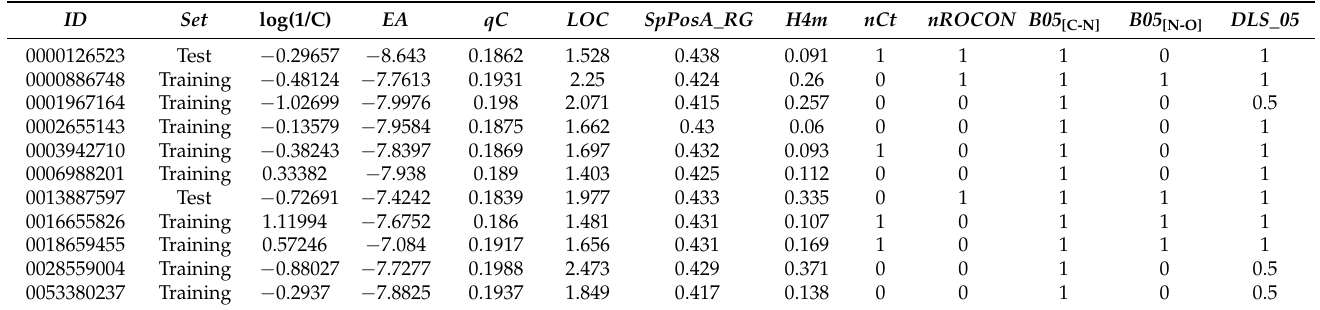
Table 1. Model data for twelve compounds randomly selected; EA is in eV and qC in C, the other quantities are